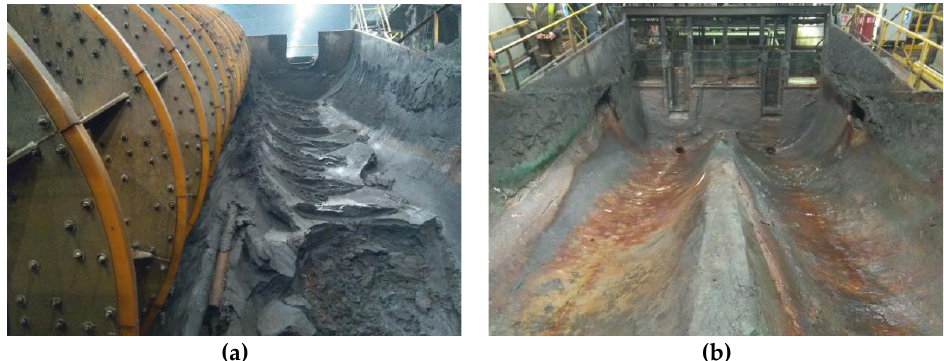
Figure 2. Preparation for anode installation: ( a ) view of the classifier with dismantled spiral; ( b ) view of the classifier with two dismantled spirals and feed removed from inside the tank.